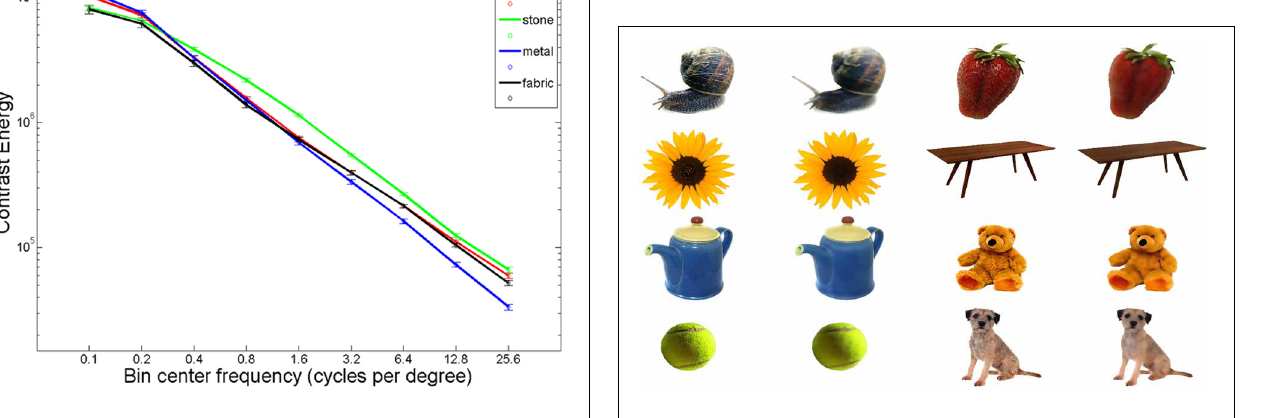
FIGURE 7 | Energy in the spatial frequency bands for the material images, per material